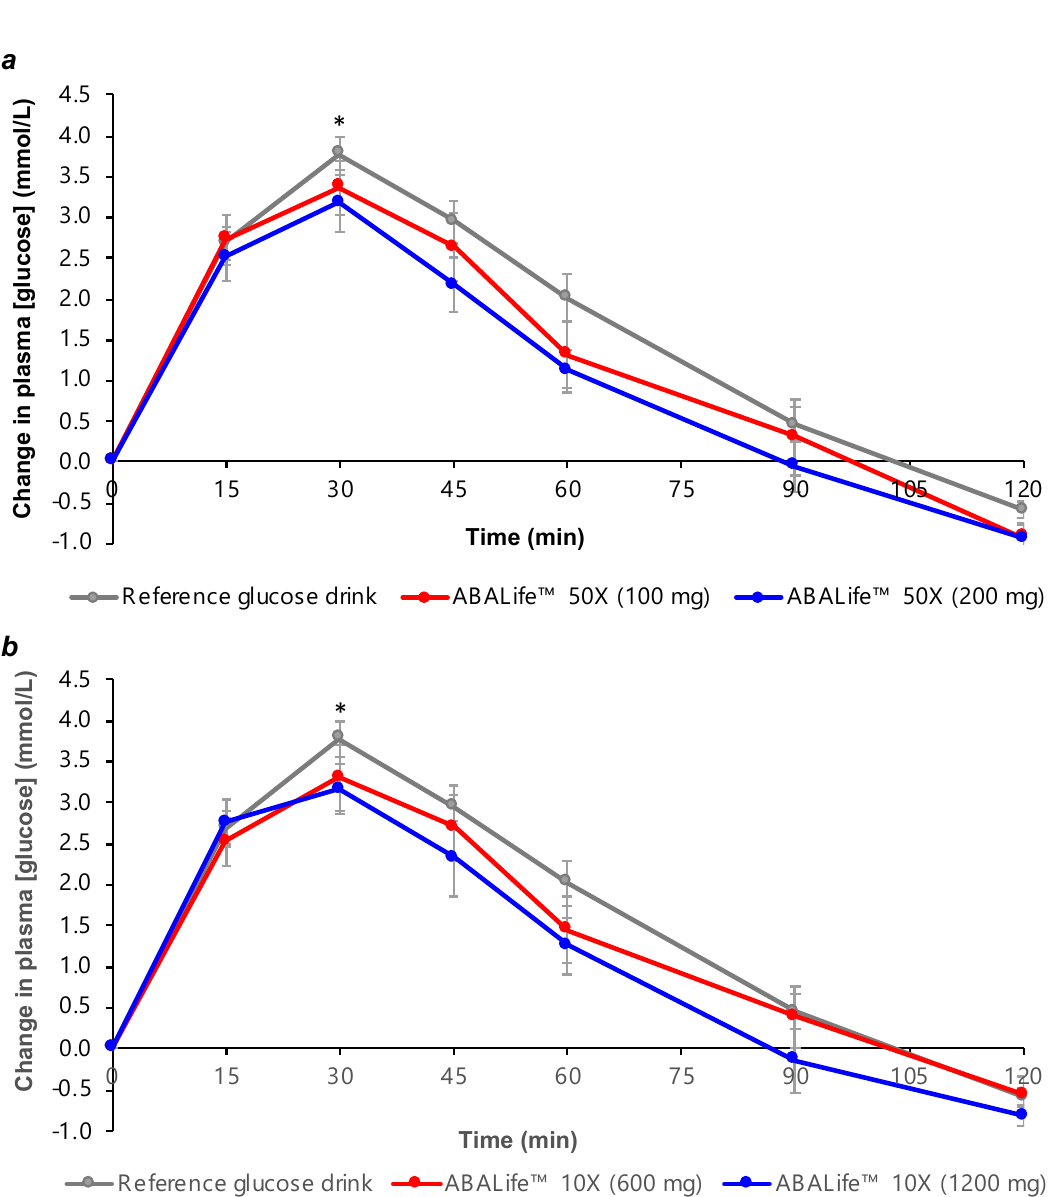
Figure 1. Change in postprandial 2 h plasma glucose concentration in healthy adults for ( a ) the two doses of abscisic acid (ABA) Life ™ 50 × fig fruit extract consumed with a glucose solution; ( b ) the two doses of ABA Life ™ 10 × fig fruit extract consumed with a glucose solution. Data are mean ± standard error mean (SEM), n = 10 for the 3 repeated tests in each participant for the reference glucose drink, and n = 10 for each test drink containing fig fruit extract (FFE). The two lower doses of each fig fruit extract contained 40 µ g of abscisic acid (shown in red), and the two higher doses of each fig fruit extract contained 80 µ g of abscisic acid (shown in blue). * indicates a significant di ff erence between peak 30 min glucose concentration for the high ABA dose test drinks (200 mg FFE-50 × and 1200 mg FFE-10 × ) compared to the reference food ( P ≤ 0.037).